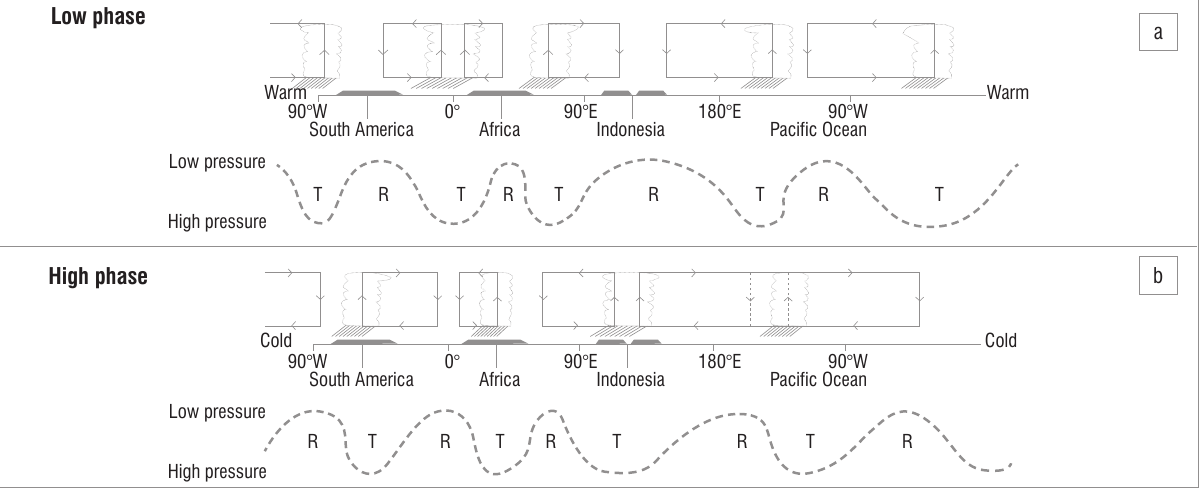
90°W South America Africa Indonesia Pacific